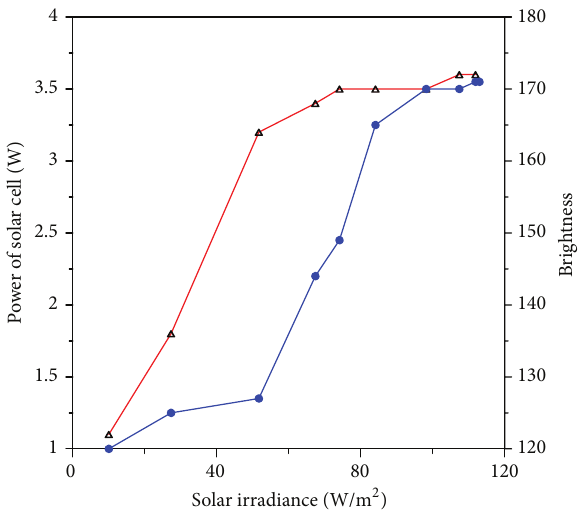
Figure 16: Solar irradiance, brightness with power of solar cell analysis.